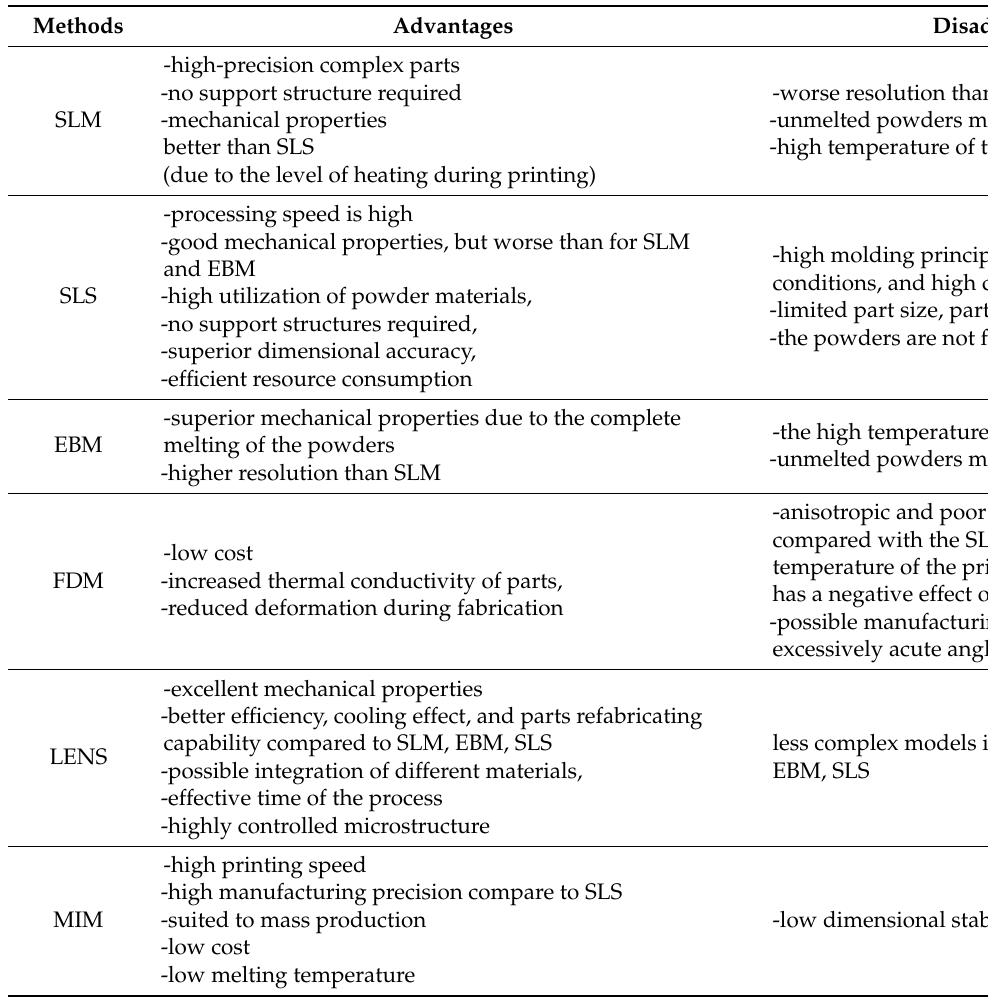
Table 3. Comparison of the different additive manufacturing technologies available for the fabrication of titanium scaffolds